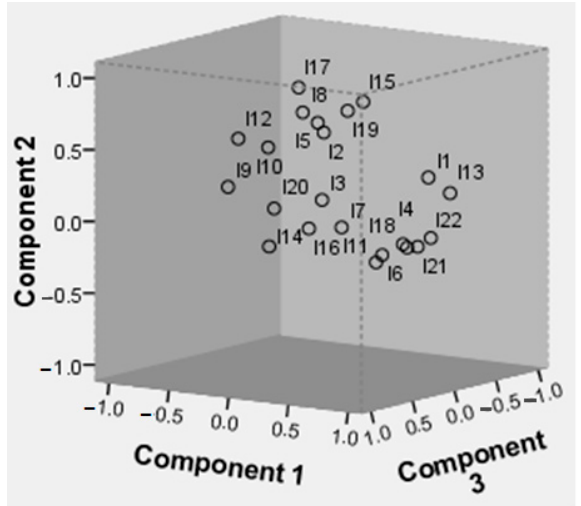
Figure 5. Component plot in a rotated space: 3D (f1, f2, and f3). Extraction method: PCA; rotation method: Varimax with Kaiser Normalization.